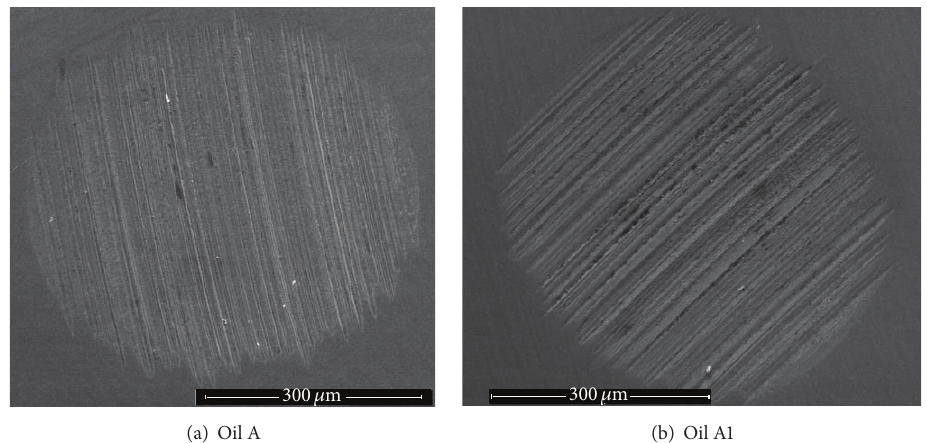
Figure 5: SEM images of ball after 1 hr test (a) ball run on Oil A and (b) ball run on Oil